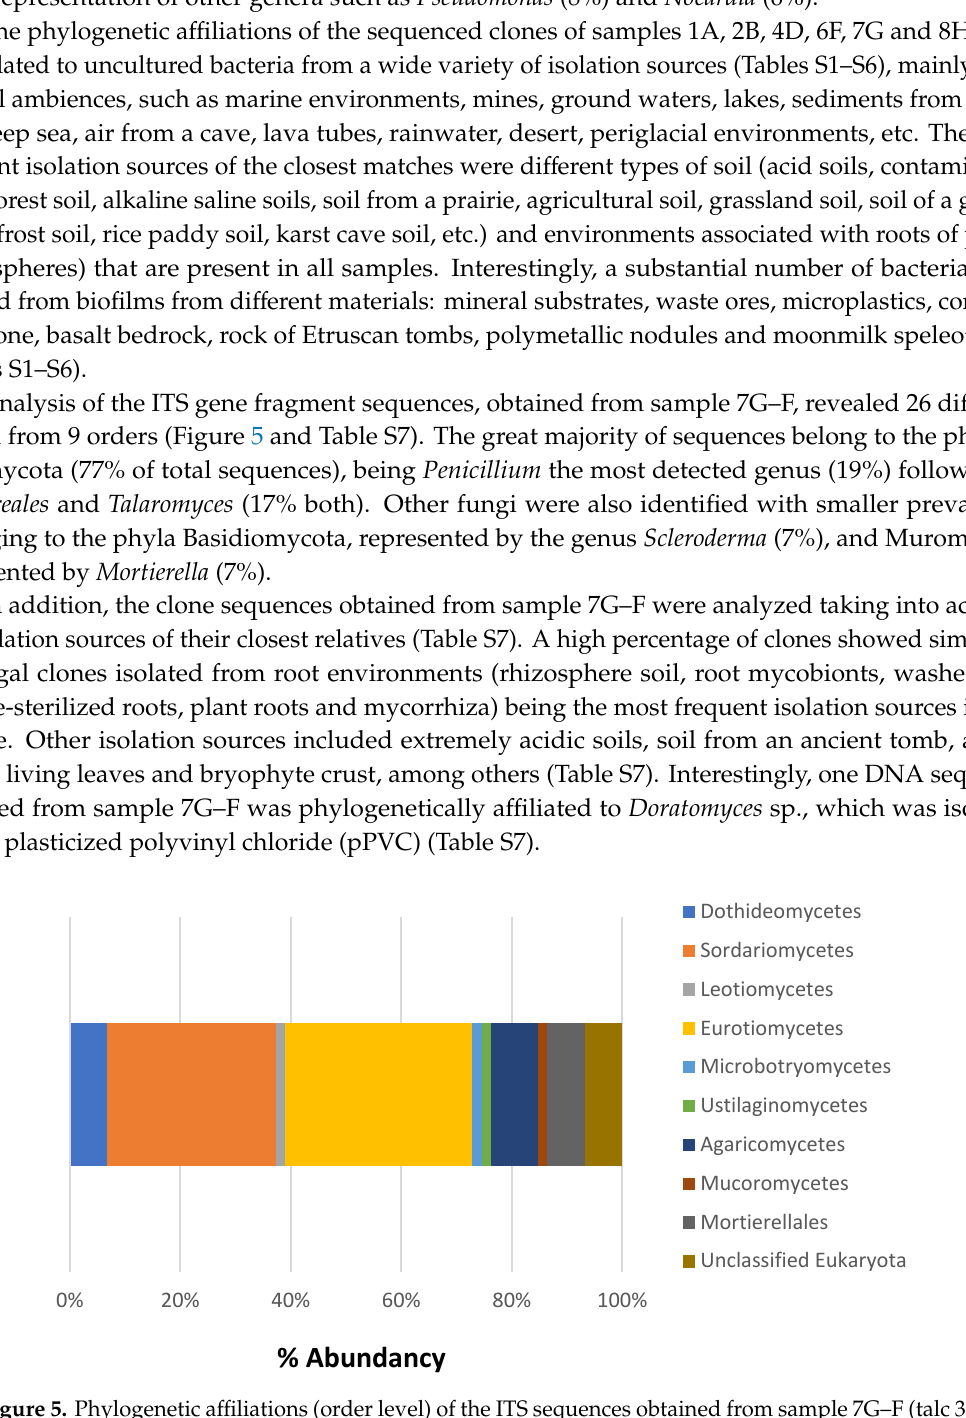
Figure 5. Phylogenetic affiliations (order level) of the ITS sequences obtained from sample 7G–F (talc 3).